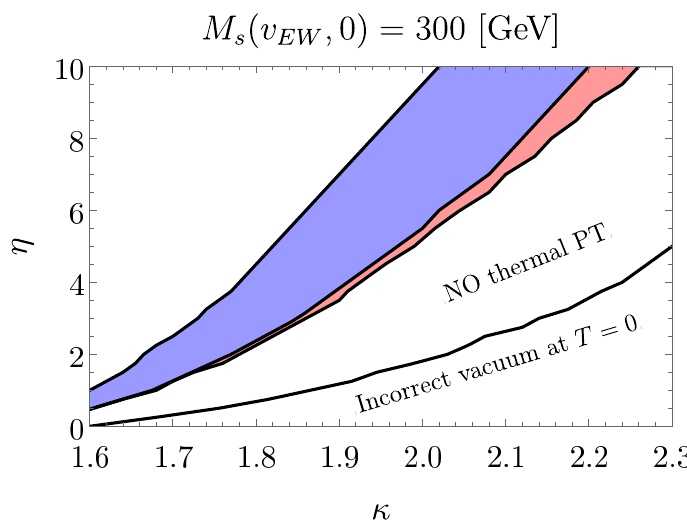
Figure 11 . Here is presented the same results found in figure 6 of ref. [49]. It has to be noted that these results are obtained with only the thermal potential and without Daisy resummation, i.e. without thermal masses. The relation with our parameters is ( λ s , λ hs ) = ( η, 2 κ ) and M s ( v EW , 0) = 300